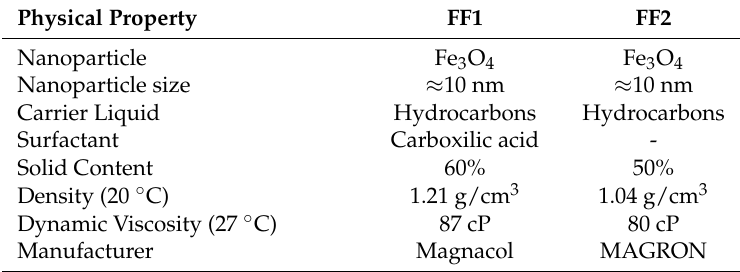
Table 2. Physical properties of FF1 and